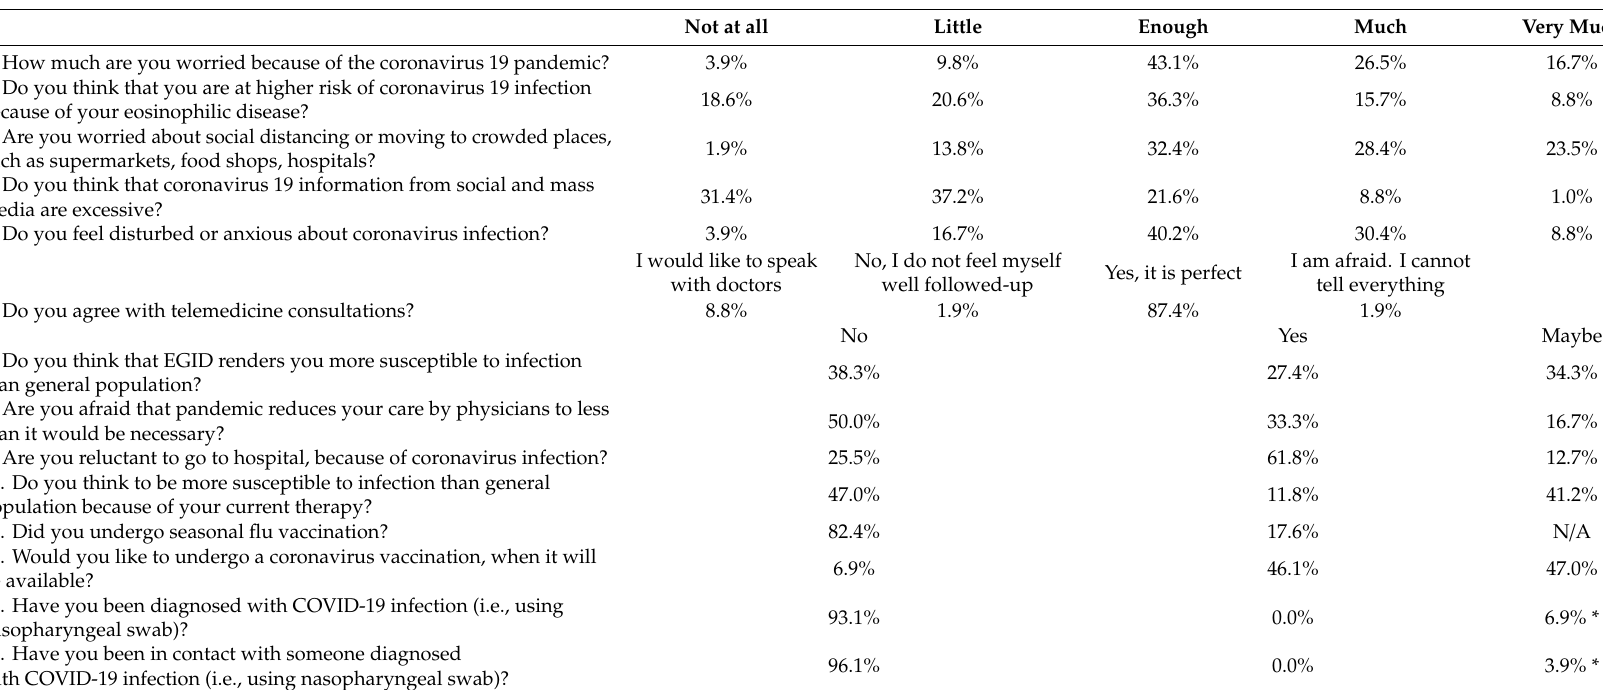
Table 2. Survey administered to eosinophilc gastrointestinal diseases (EGIDs) patients for evaluating COVID-19 perception and infection occurrence. Not at all Little Enough